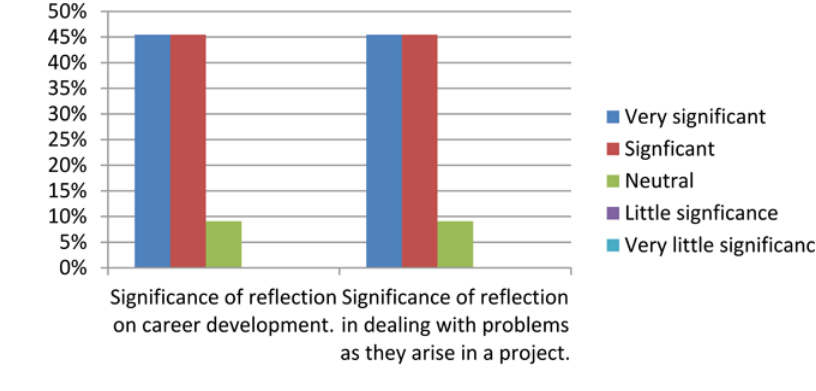
The significance of reflection on career development and the management of project